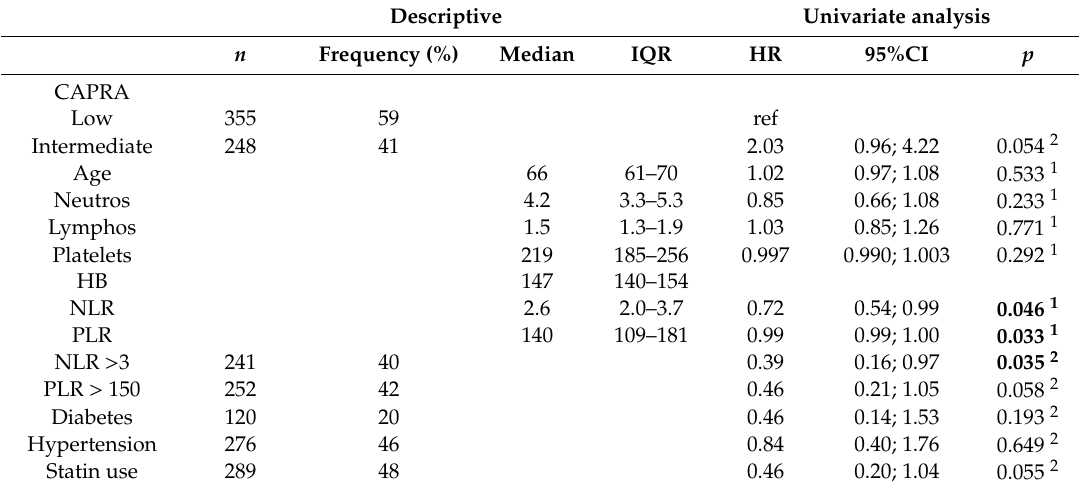
Table 1. Patient characteristics ( n = 628).